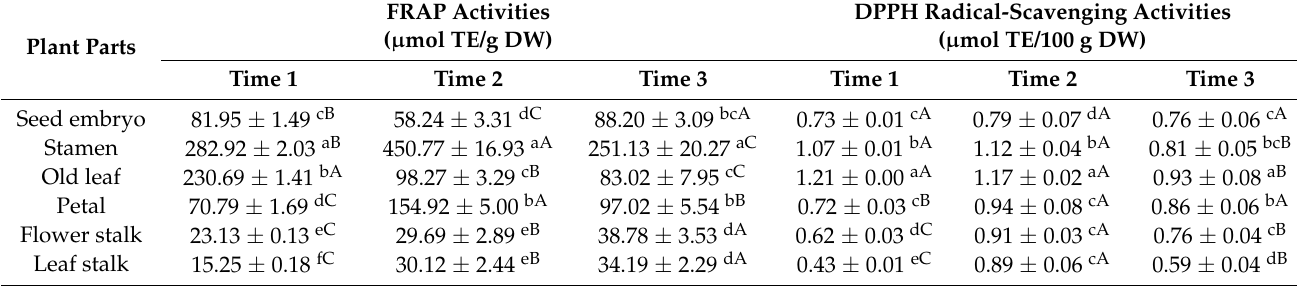
Table 4. Antioxidant activities measured by ferric ion-reducing antioxidant power (FRAP) and 2,2- diphenyl-1-picrylhydrazyl (DPPH) radical-scavenging assays of different sacred lotus parts collected from different time periods.